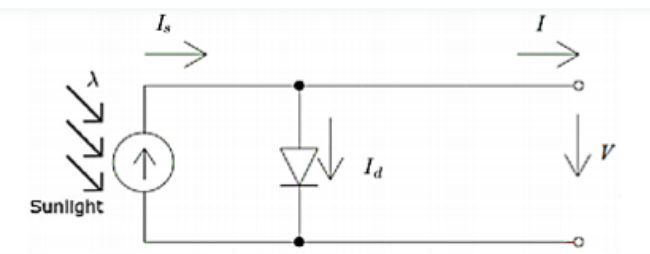
Figure 10. Equivalent circuit of a PV cell (1 diode and 3 parameters model-1M3P). This model has three parameters: I s , I 0 , and n